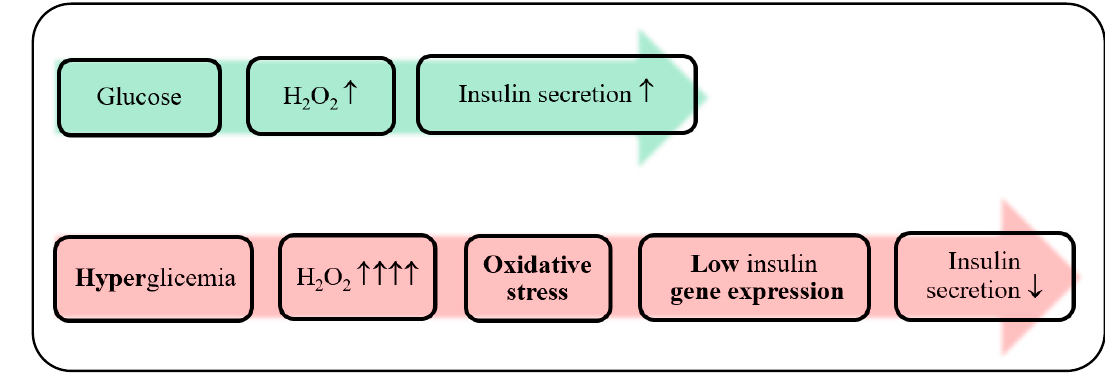
Figure 14. Schematic representation of a model of H 2 O 2 as a signal in blood glucose-stimulated insulin secretion.